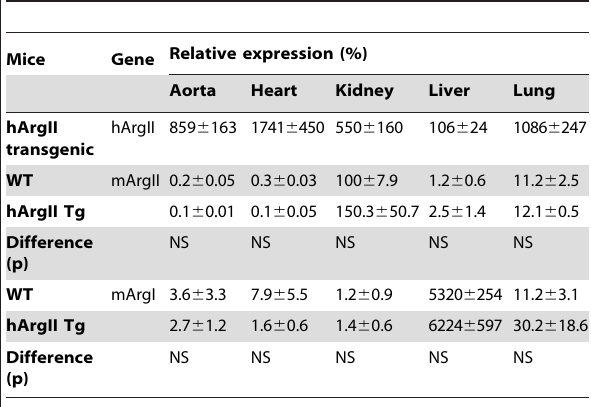
Table 1. Expression of hArgII, mArgI and mArgII mRNAs in tissues of female C57Bl/6NT and hArgII transgenic mice.